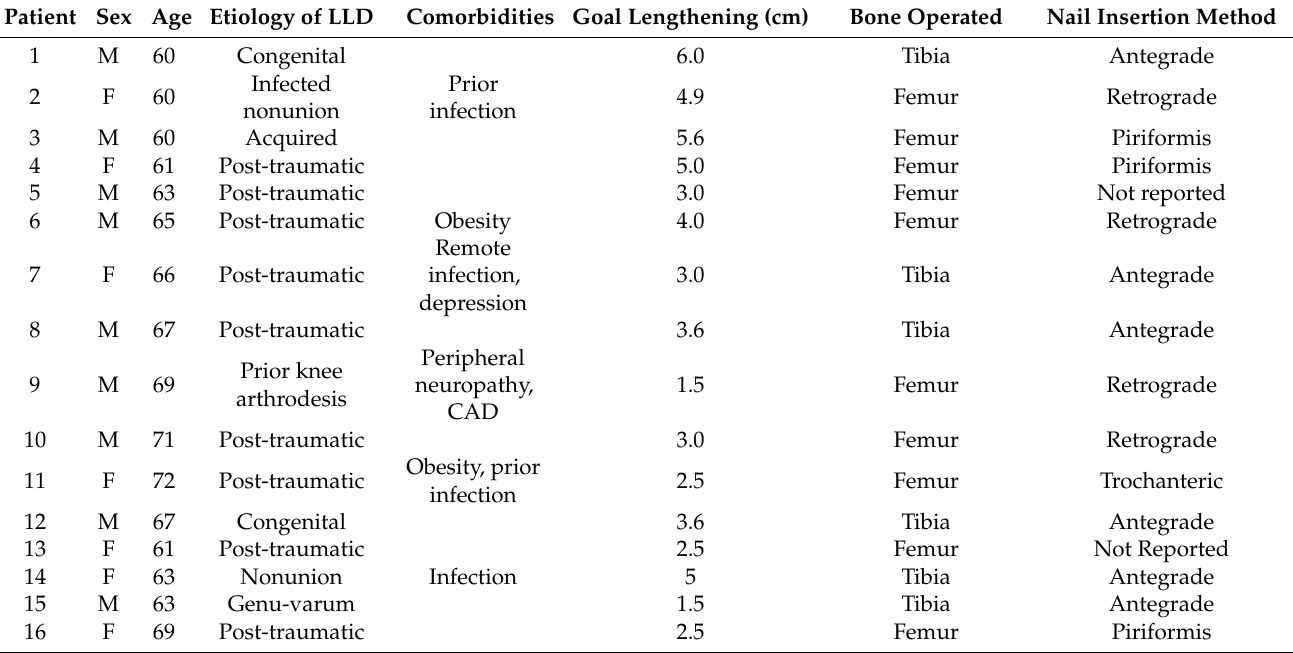
Table 1. Characteristics of patients aged ≥ 60 years.